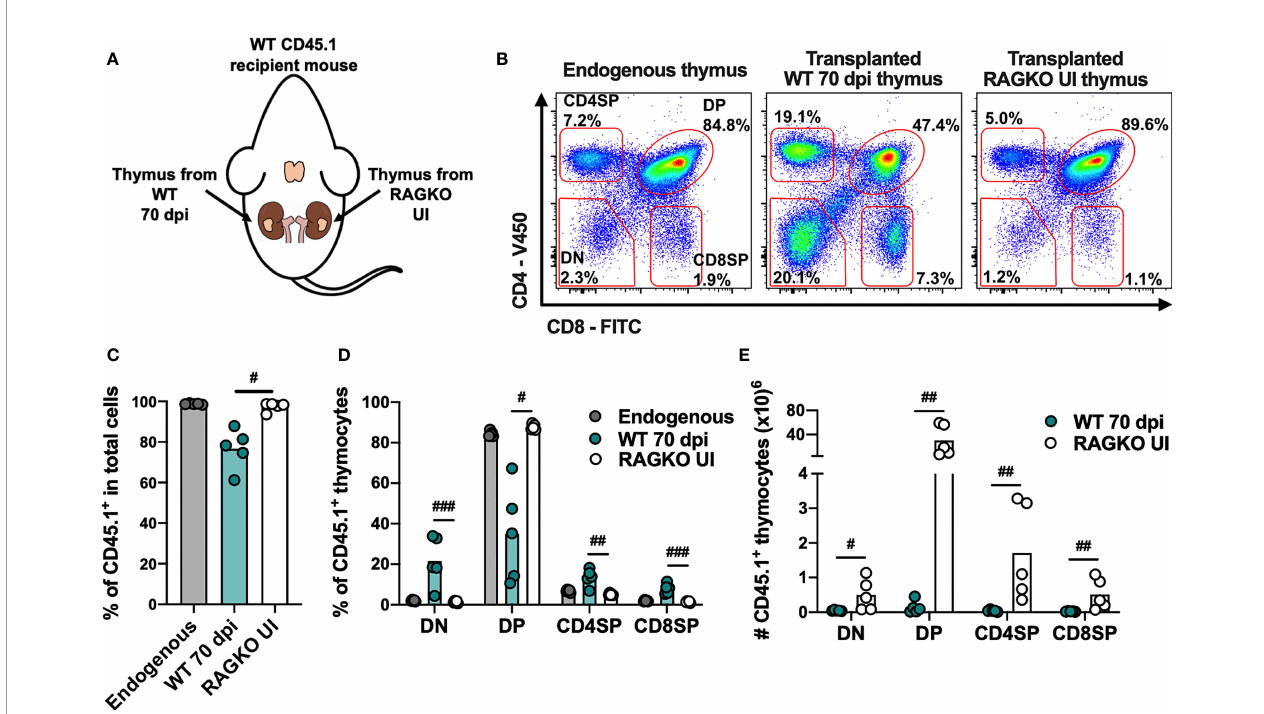
FIGURE 6 | Thymic stroma from WT mice infected with M. avium 25291 does not properly support T cell differentiation. (A) Experimental schematic representation of thymi transplant from M. avium infected WT mice (70 dpi) and uninfected RAGKO mice (both CD45.2) under the kidney capsule of WT CD45.1 recipient mice. Mice were euthanized 4 weeks after transplant. (B) Representative plots of the CD45.1 + four main thymocyte populations (DN, DP, CD4SP and CD8SP) from WT CD45.1 recipient mice endogenous thymi, and from transplanted WT infected and RAGKO uninfected thymi. (C) Percentage of cells recruited from the recipient mouse (CD45.1 + ), and (D) percentage and (E) number of cells from the four main thymocyte populations from endogenous thymi of WT CD45.1 recipient mice (grey), or from transplanted thymi from 70 days M. avium 25291 infected WT mice (teal) or uninfected RAGKO mice (white). Data represent the mean from fi ve mice per group from one of two independent experiments. Comparisons between WT 70 dpi and uninfected RAGKO were performed by 2-tailed ratio paired t test and marked as: # p < 0.05, ## p < 0.01, ### p < 0.001. UI stands for uninfected. dpi stands for days post infection. DN stands for double negative. DP stands for double positive. SP stands for single